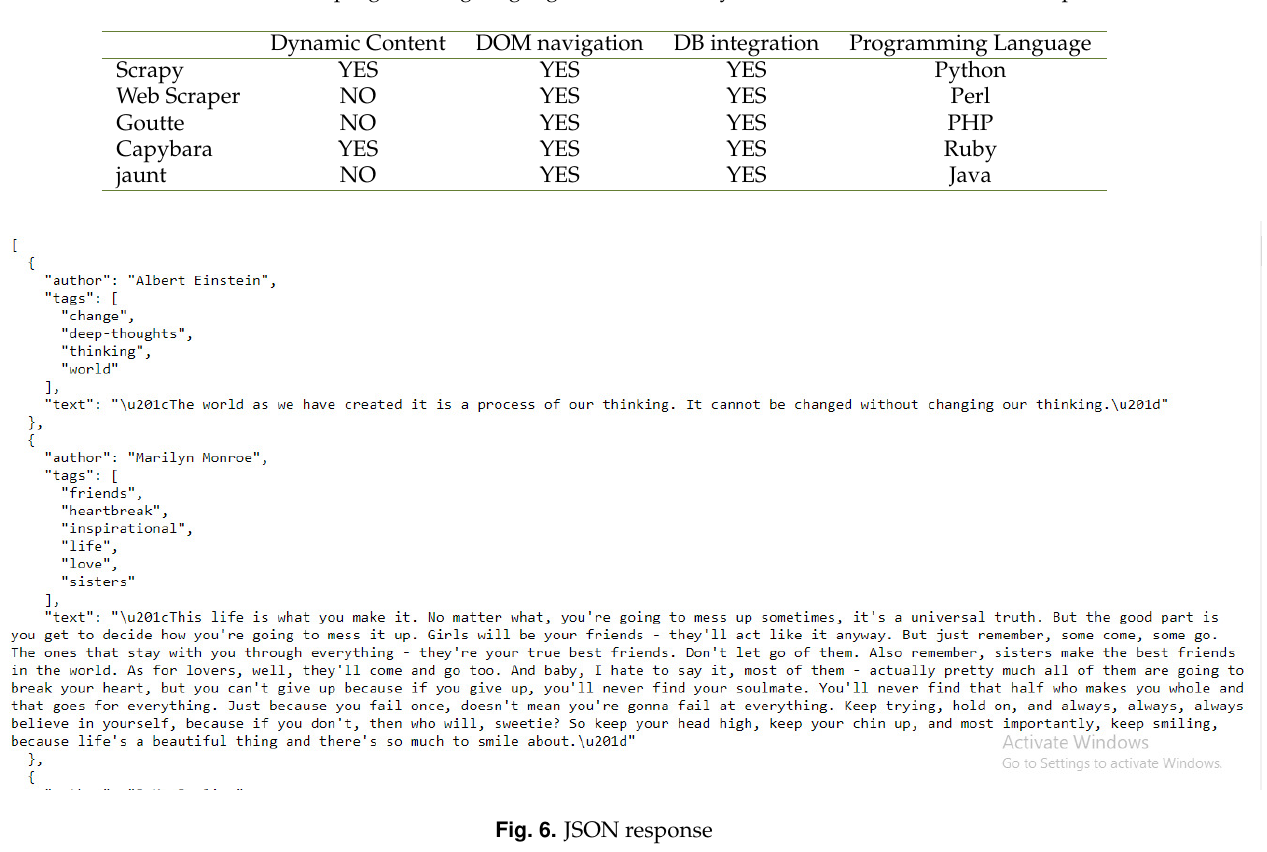
Table 2. Frameworks for five programming languages the availability of three basic functionalities is